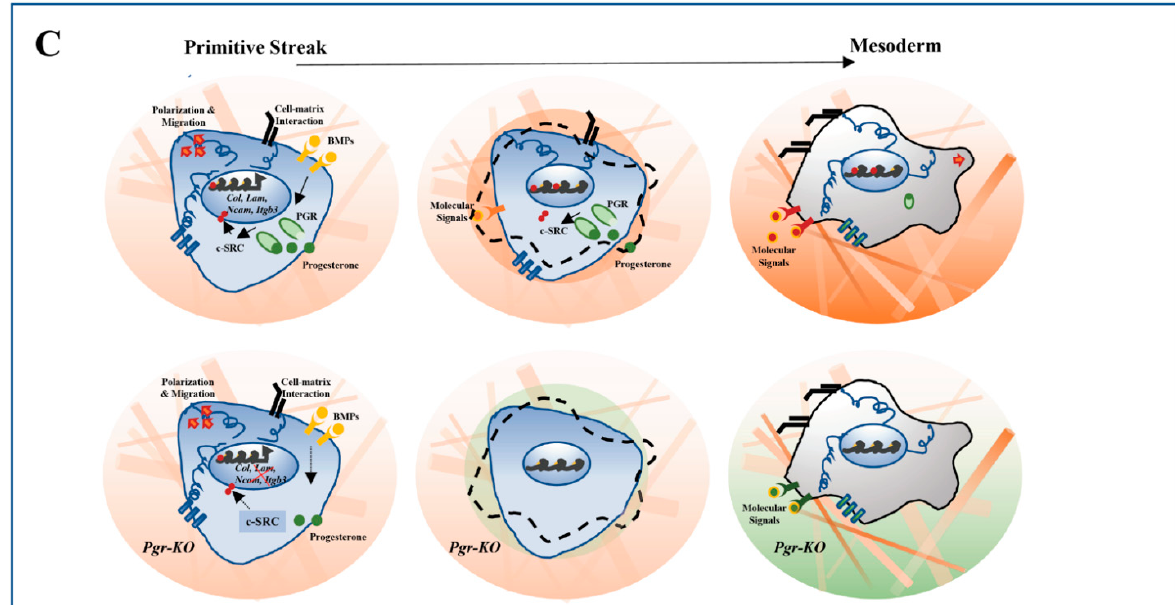
Figure 6. PGR influences cell-ECM, cell-cell interactions and cytoskeletal remodeling of mesoderm progenitors. ( A ) GO-term enrichment analysis of genes differentially expressed in WT and Pgr-KO PPS displays significant overrepresentation of terms associated with ECM interactions, cell adhesion, and cytoskeletal protein binding (Fisher’s exact test with Bonferroni correction). ( B ) Heatmap indicating downregulation of Laminins, Collagens, and actin remodeling transcripts in APS and PPS with moderate changes in the PS signature genes. In ExM and CM, adhesion and ECM genes are downregulated in Pgr-KO , with the exception of Itgb3 , which is specifically upregulated in the ExM and Ncam 1, which is upregulated in CM. ( C ) PGR-KO cells show altered expression of genes related to cellular adhesion, cytoskeleton remodeling, and ECM composition. Changes in the cellular interactions with the direct environment alter the differentiation program and affect the balanced production of mesoderm types.